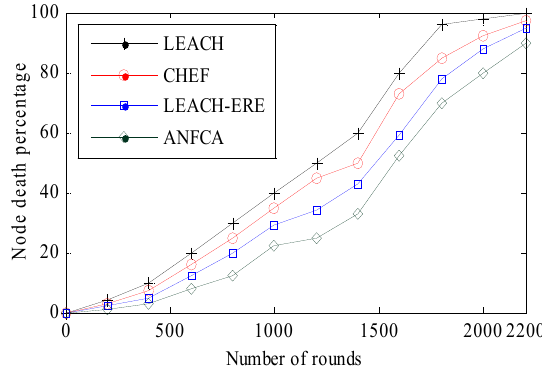
Figure 7. Node death percentages over the rounds.